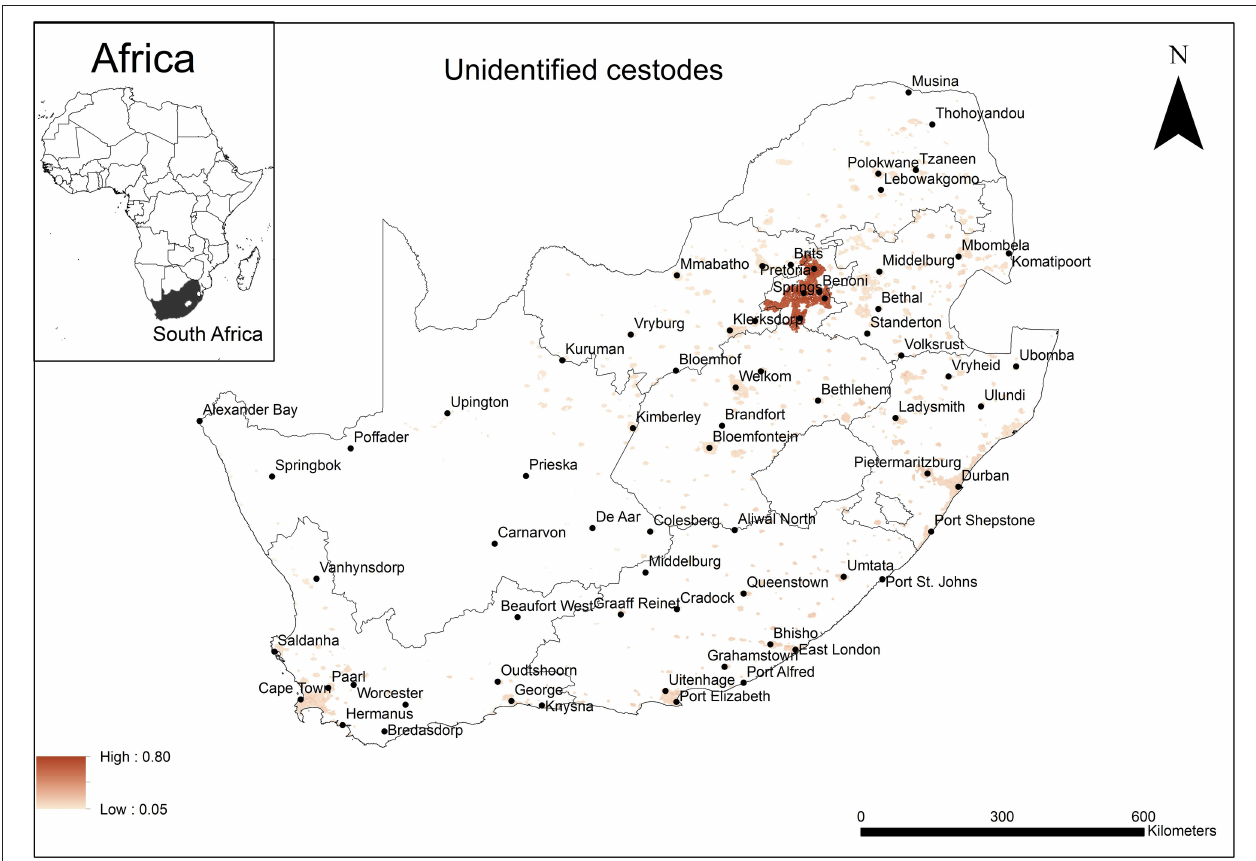
FIGURE 3 | A map showing predicted occurrence of rodent-borne cestodoses in South Africa based on environmental suitability (shaded areas). White (non-shaded) areas represent areas where data were unavailable.